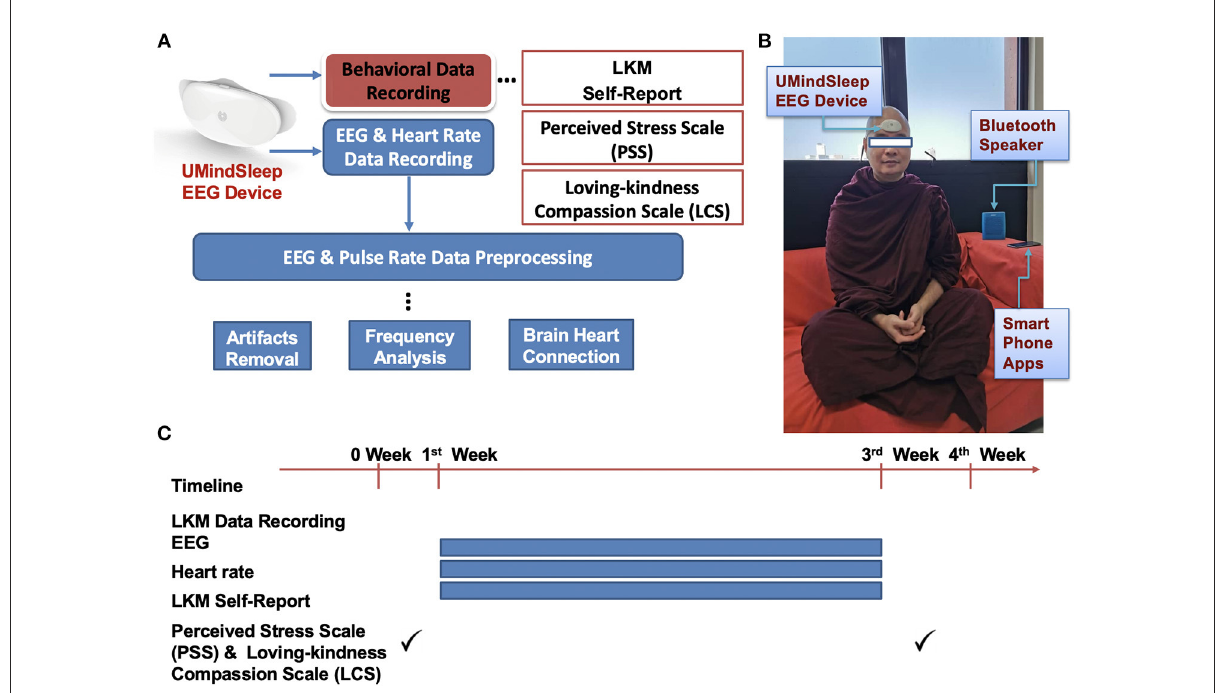
FIGURE1 Illustration of data collection and analysis. (A) Experimental structure of data collecting. (B) A real experimental demonstration. ( C) The experimental timeline lasted for 3 weeks. Self-report was collected in each session. Perceived Stress Scale (PSS) and Loving-kindness Compassion Scale (LCS) were collected before the first session and after the last session.